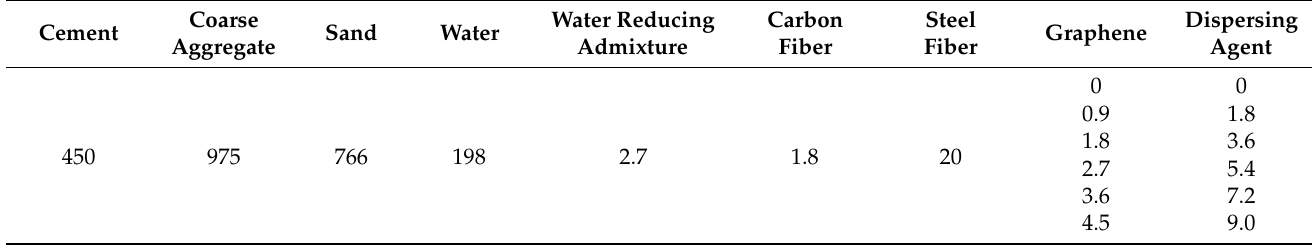
Table 4. Proportion of graphene composite conductive concrete (kg/m 3